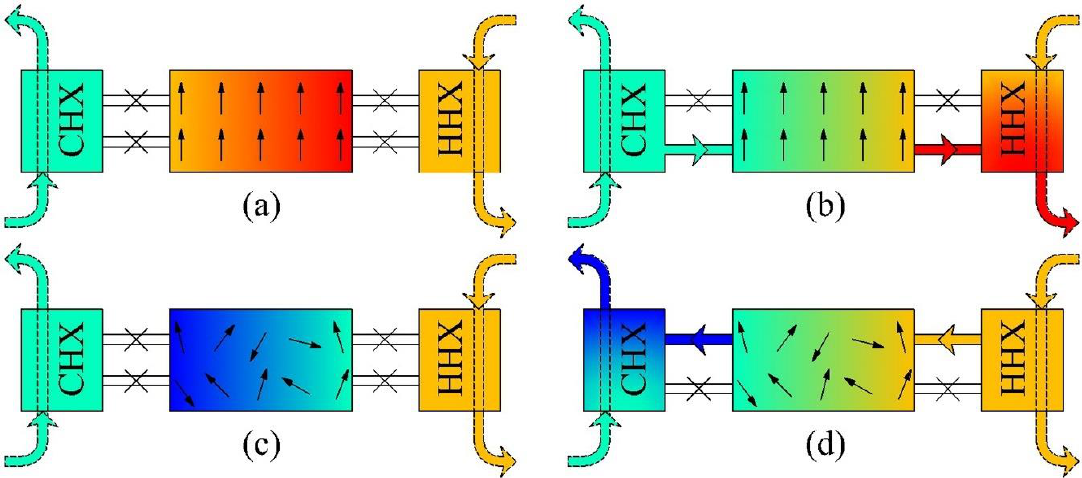
Figure 1. Schematic description of a magnetic refrigeration cycle: ( a ) magnetization, ( b ) hot heat transfer, ( c ) demagnetization, ( d ) cold heat transfer with a cold heat exchanger (CHX) and hot heat exchanger (HHX).